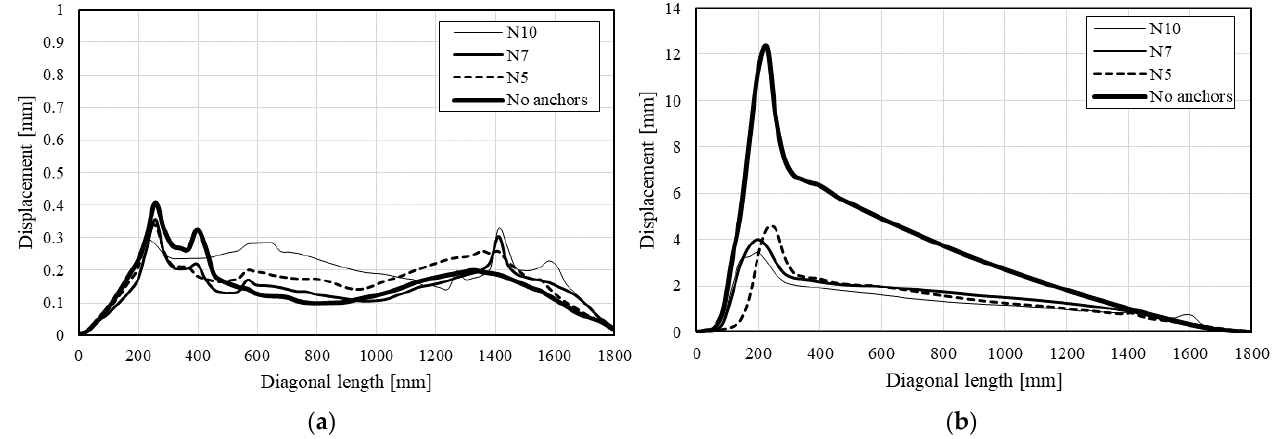
Figure 22. Out-of-plane displacement along the diagonal for different numbers of anchors: ( a ) at peak load, ( b ) at failure.